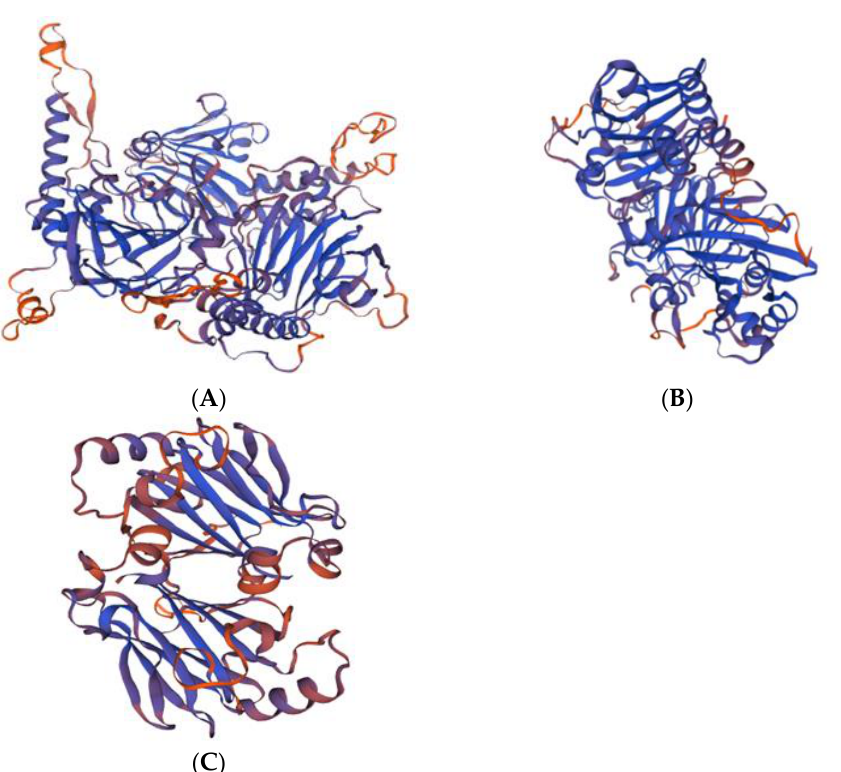
Figure 4. Secondary structure of SMAD4 ( A ), SMAD5 ( B ) and SMAD7 ( C ).